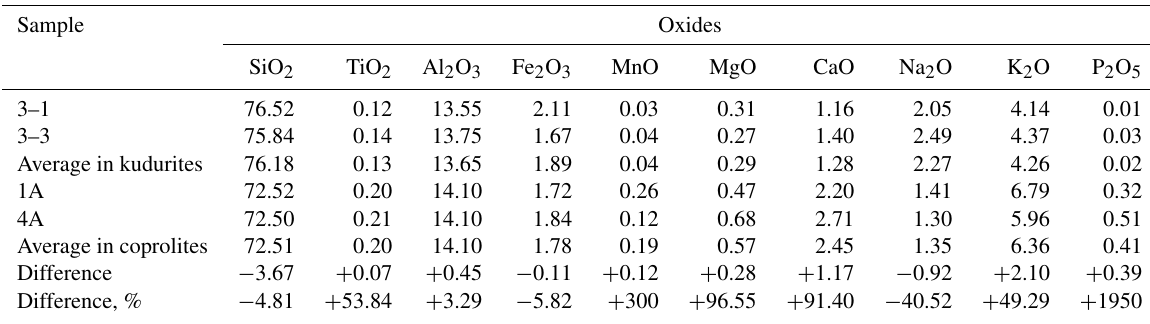
Table 3. The results of comparing the chemical compositions of kudurites and analogous coprolites gathered in the area of the Bolshoi Shanduisky